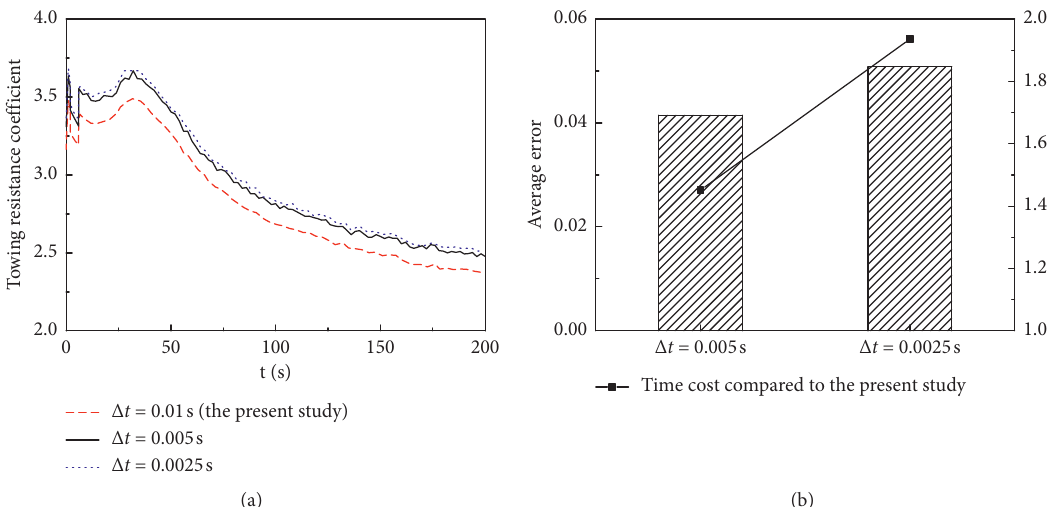
Figure 8: The towing performance comparisons of different time steps: (a) the time series of towing resistance coefficient at the towing speed of 4kN and (b) the average error and time cost ratio statistics compared to the present study.